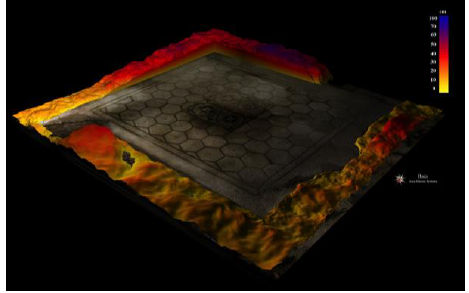
Fig. 10 - Laser scanner relief. Color progression from yellow to blue indicates different highs. (ISCR Archive)